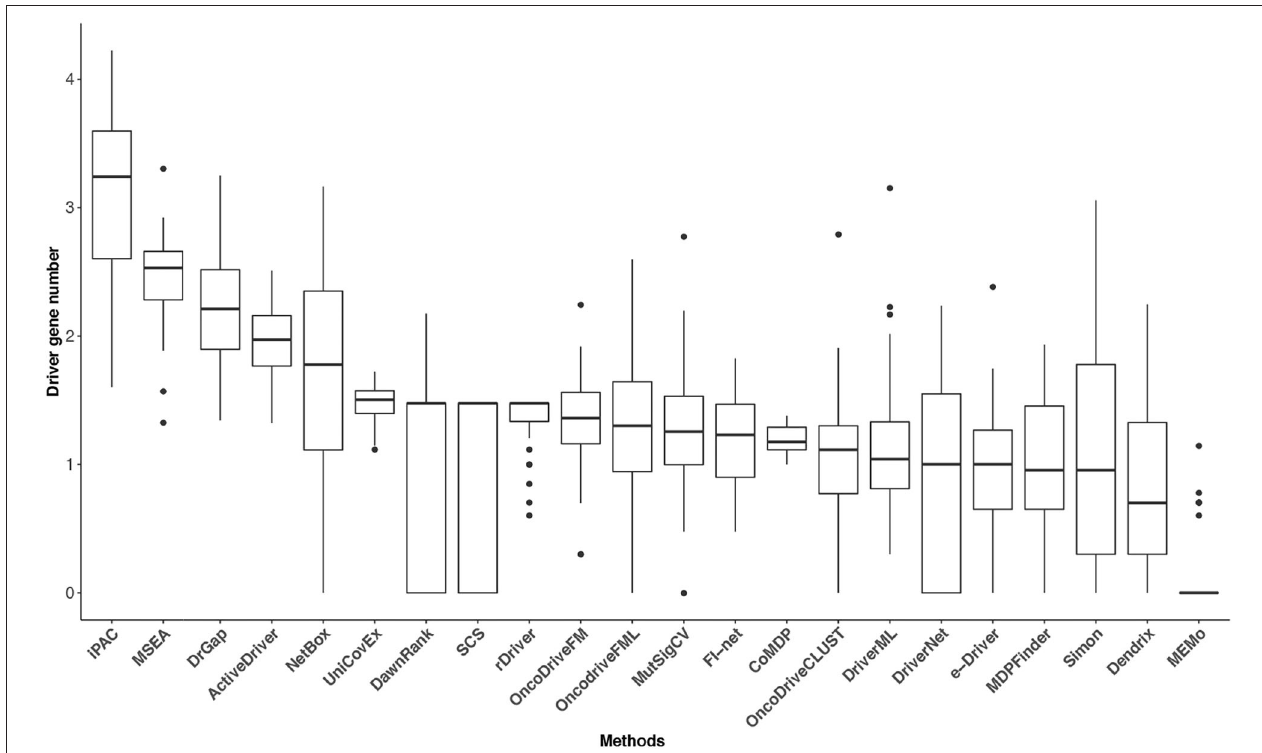
FIGURE 4 | The driver gene number (on a log-10 scale) of the 22 methods in the 31 TCGA datasets. The numbers of driver genes predicted by different methods differ